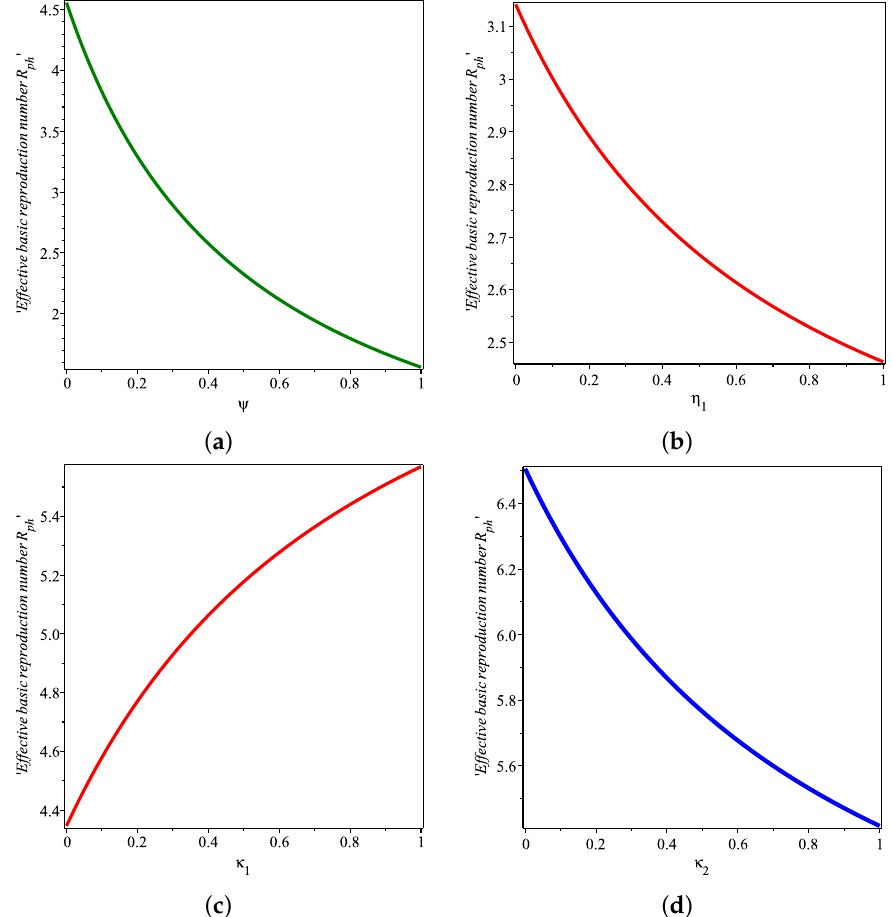
Figure 3. The relationship between ψ ( a ), η 1 ( b ), κ 1 ( c ), and κ 2 ( d ) and the effective reproduction number R ph